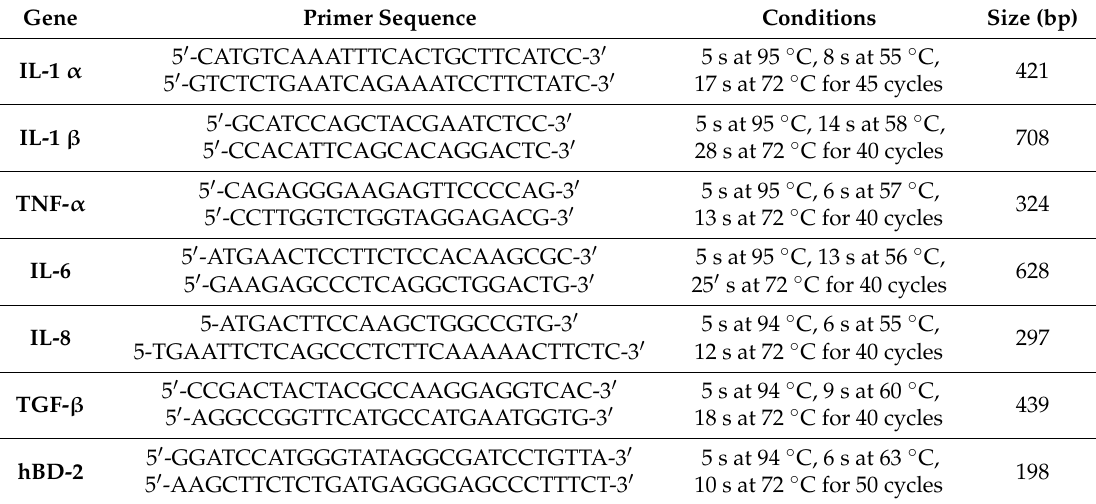
Table 1. Real-time PCR conditions for HaCaT